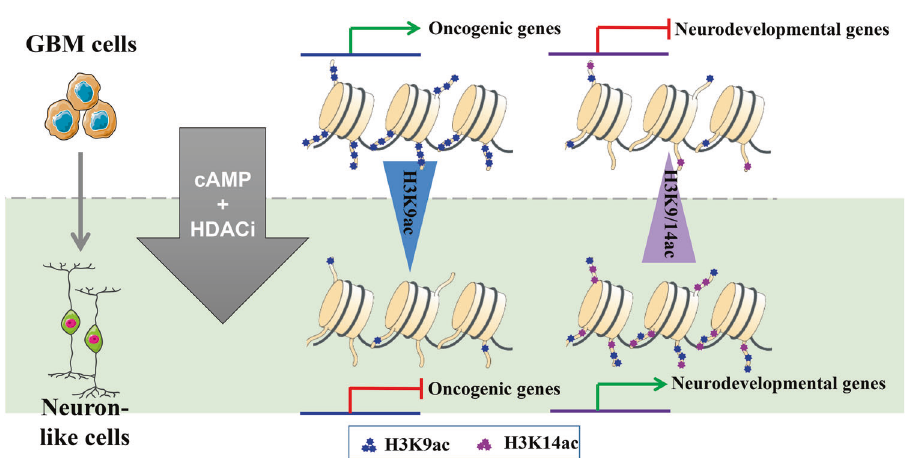
Fig. 8 Illustration of a model on differential regulation of H3K9/H3K14 acetylation reshaping glioma cells into neuron-like cells. In Brief, this study shows that glioblastoma cells can be differentiated into neurons by a combination of cAMP activator and HDAC inhibitor. Mechanistically, ChIP-seq and RNA-seq illustrate that the drug combination can speci fi cally decrease the level of H3K9ac in oncogenes and increase the level of H3K9ac and H3K14ac in differentiation genes to reshape glioma cells into neuron-like